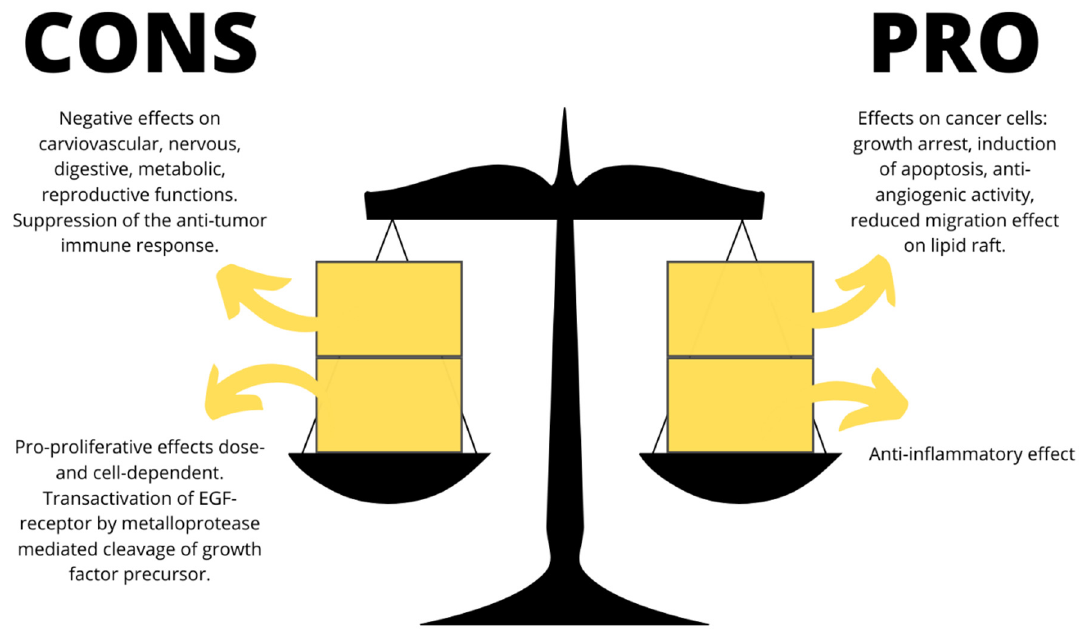
Figure 3. Pros and cons of the endocannabinoid system as a promising antitumor therapeutic strategy.